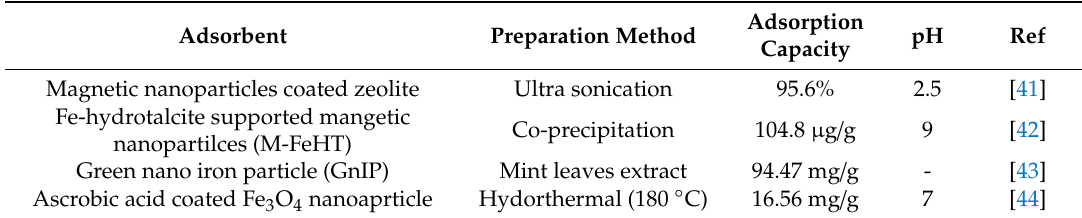
Table 3. Comparison of iron nanomaterial adsorbent for As(V)